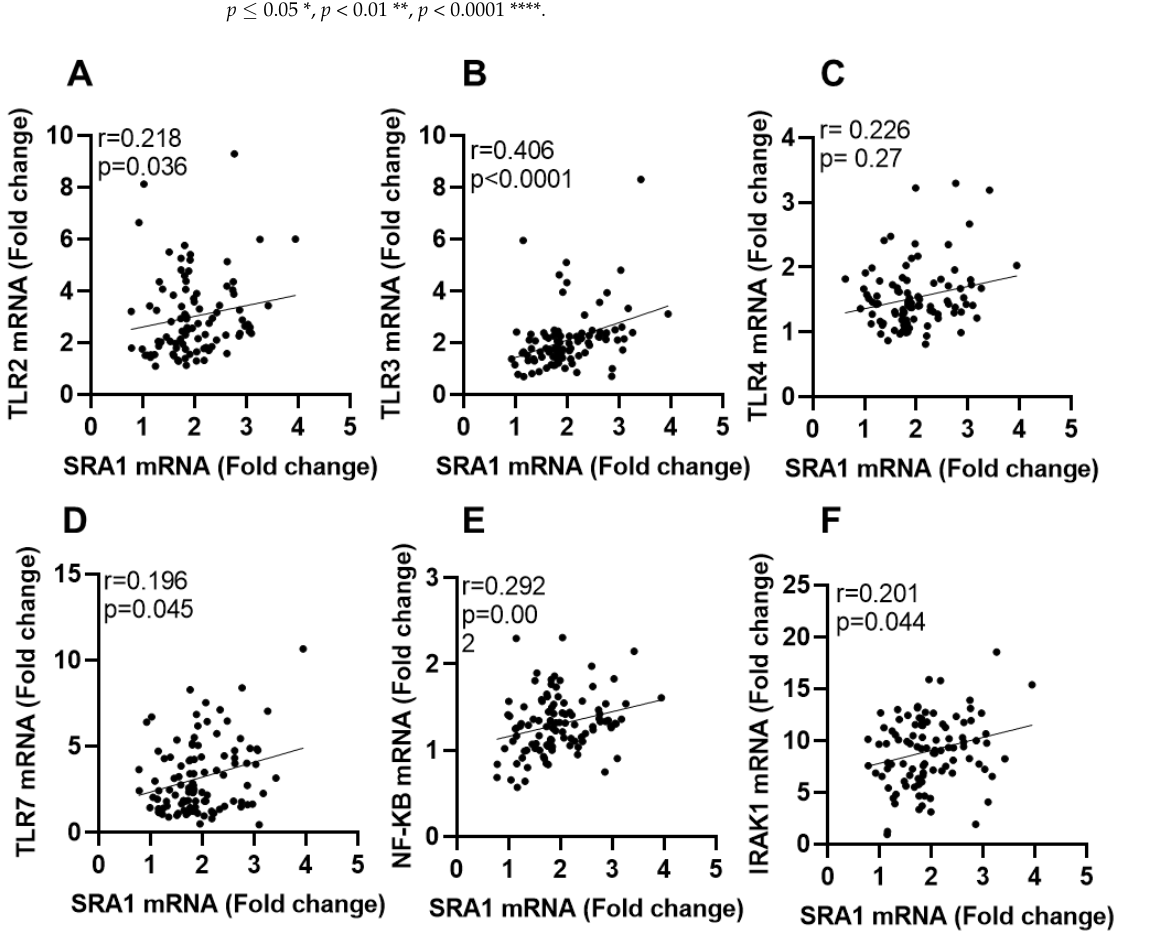
Figure 2. Adipose tissue SRA1 gene expression is correlated with TLRs and signaling molecules. Subcutaneous adipose tissues were obtained from lean, overweight, obese individuals. In this case, mRNA expression of SRA1, TLR2, TLR3, TLR4, TLR7, IRAK1 and NF-kB was detected by real-time RT-PCR and represented as fold change over controls. ( A – F ) In the studied population, SRA1 transcript levels, in adipose tissue, are positively correlated with TLRs and their signaling molecules.